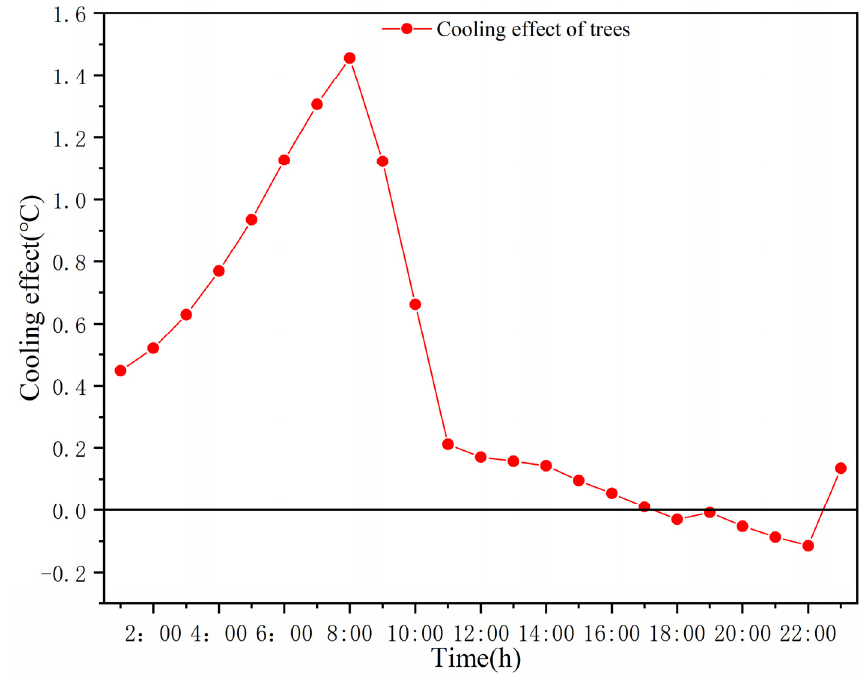
Figure 13. The hourly cooling effect of trees.